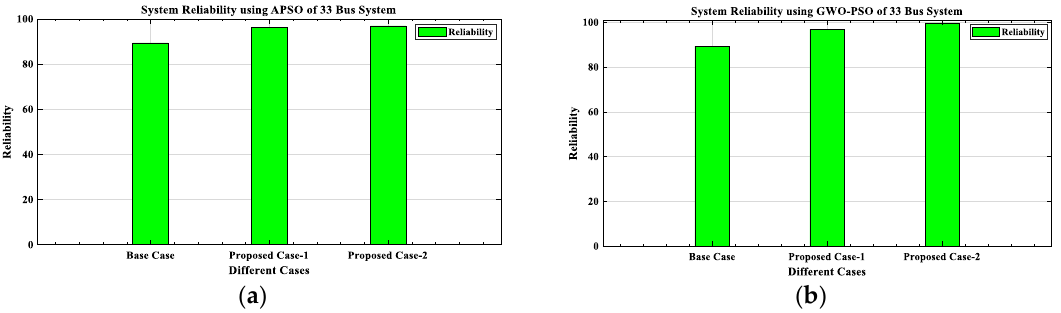
Figure 17. Proposed cases 𝑀𝑂 𝐹𝐹 of the 33-bus RDN; ( a ) APSO, ( b ) GWO-PSO.